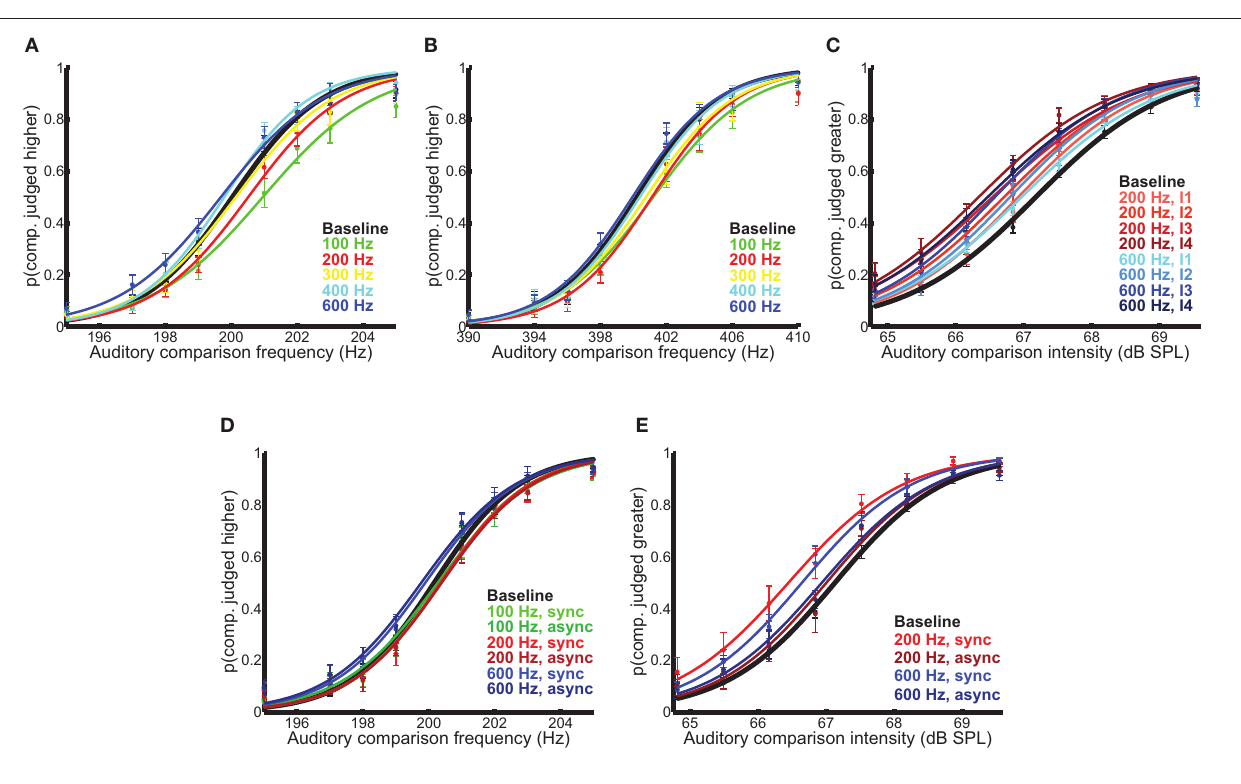
condition. Error bars indicate SEM. (A) Frequency discrimination experiment with the 200-Hz standard. (B) Frequency discrimination experiment with the 400-Hz